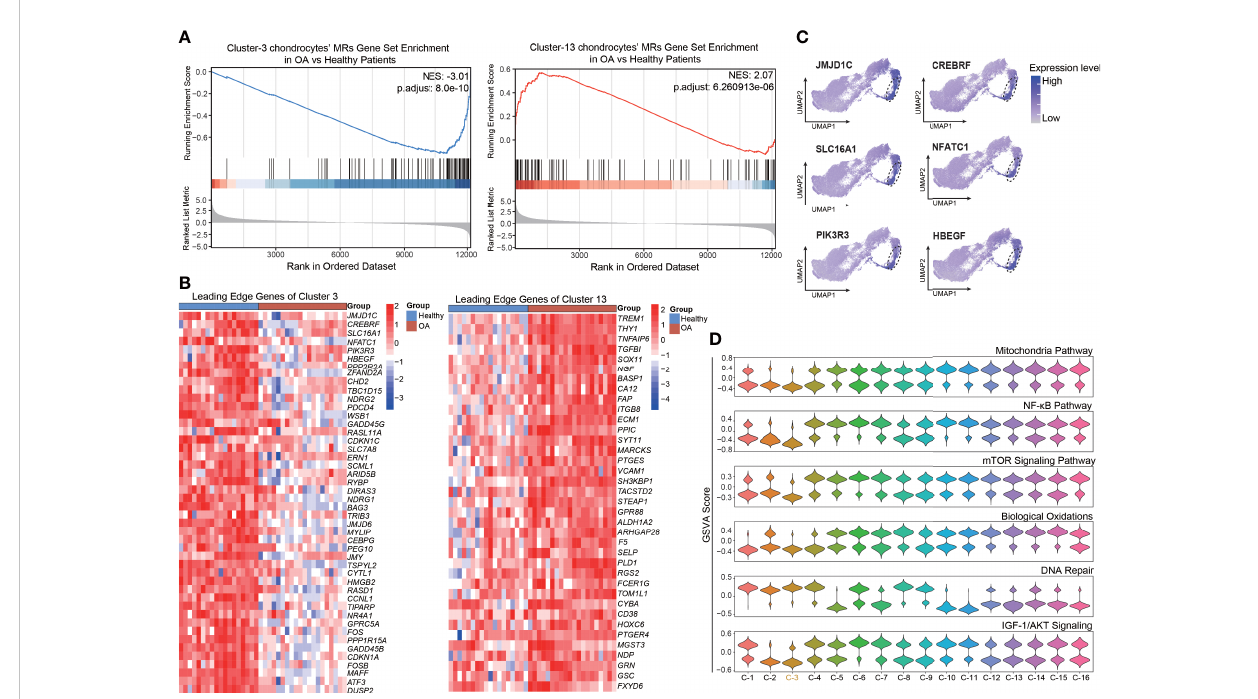
FIGURE 3 Enrichment of top master regulator proteins of cluster3 and cluster13 from inferred proteomic data in bulk RNA-seq data is associated with OA progression. (A) Gene set enrichment analysis (GSEA) of top 100 master regulator proteins of cluster3 and cluster13 from inferred proteomic data in ranked differential expressed genes list of bulkRNA-seq data from 20 patients with OA versus 18 patients with normal cartilage. (B) Heatmap of leading-edge protein set of protein activity-based cluster 3 and cluster 13 from GSEA analysis. (C) Dot plots showing the top 6 leading-edge protein of cluster 3 based on VIPER-inferred protein activity on the umap. (D) Violin plots showing the gene set variation score of DNA Repair signaling pathway, NF-kB signaling pathway, mTOR signaling pathway, Mitochondria pathway, Biological Oxidations, and IGF-1/AKT signaling pathway in various protein activity-based cell